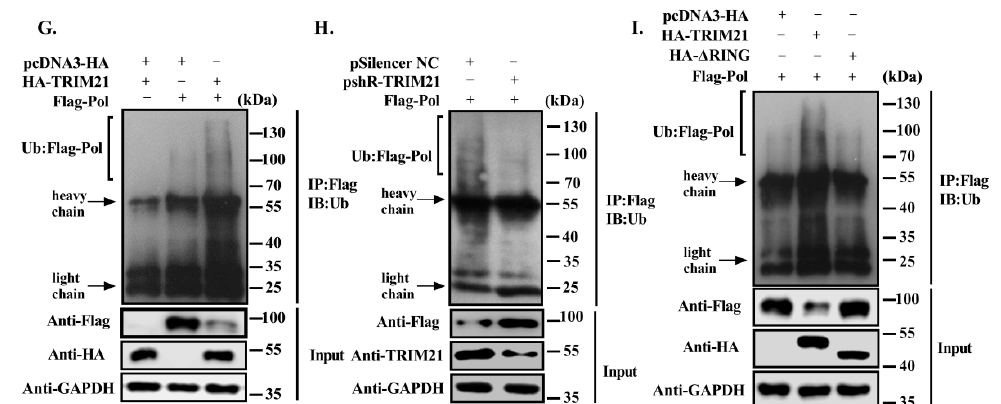
Figure 4. TRIM21 promotes the degradation of HBV DNA Pol through the ubiquitin proteasome pathway via its RING domain. ( A ) Huh7 cells were transfected with FLAG-HBV DNA Pol expression plasmid. After 30 h, the cells were treated with 20 µ M MG132 for 8 h, and Western blot was used to detect the protein level of HBV DNA Pol. ( B ) The cells were transfected as described in ( A ) except for using 0, 25 or 50 µ M chloroquine to treat the cells for 6h. ( C ) FLAG-HBV DNA Pol was cotransfected with pcDNA3 / pTRIM21 (left panel) or pSilencer-NC / shR-TRIM21 (right panel) in Huh7 cells, and MG132 treatment conditions were the same as in ( A ). Then, Western blot was used to detect the protein level of HBV DNA Pol. ( D ) Huh7 cells were cotransfected with FLAG-HBV DNA Pol and pcDNA3 (left panel) / pSilencer-NC (right panel) and treated with MG132 as described in ( A ), or cotransfected with pTRIM21 (left panel) / shR-TRIM21 (right panel). The protein level of HBV DNA Pol was analyzed by Western blot. ( E ) Huh7 cells were transfected with TRIM21 overexpression plasmid, and MG132 treatment was the same as in ( A ). Then, Western blot was used to detect the protein level of TRIM21. ( F ) The same as in ( B ), except for using chloroquine, and the cells were transfected as described in ( E ). ( G ) Huh7 cells were cotransfected with FLAG-HBV DNA Pol and pcDNA3 or HA-TRIM21, and the cells were treated with 10 µ M MG132. Subsequently, anti-FLAG antibody was used to precipitate the proteins for ubiquitination analysis. ( H ) The same as in ( G ), except for pSilencer-NC and shR-TRIM21, which were separately cotransfected with FLAG-HBV DNA Pol. ( I ) Huh7 cells were cotransfected FLAG-HBV DNA Pol with wild-type TRIM21, TRIM21- ∆ RING or pcDNA3. The ubiquitin antibody was used to detect the ubiquitination level of HBV DNA Pol, and the anti-FLAG antibody was used to detect the protein level. Data are representative of three independent experiments with three replicates